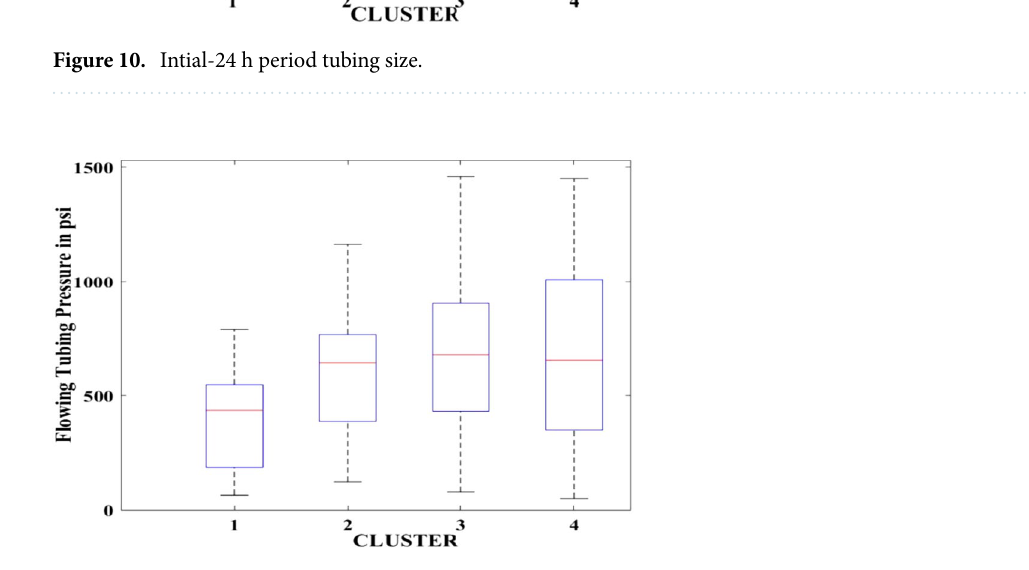
Figure 11. Initial 24-h period flowing tubing